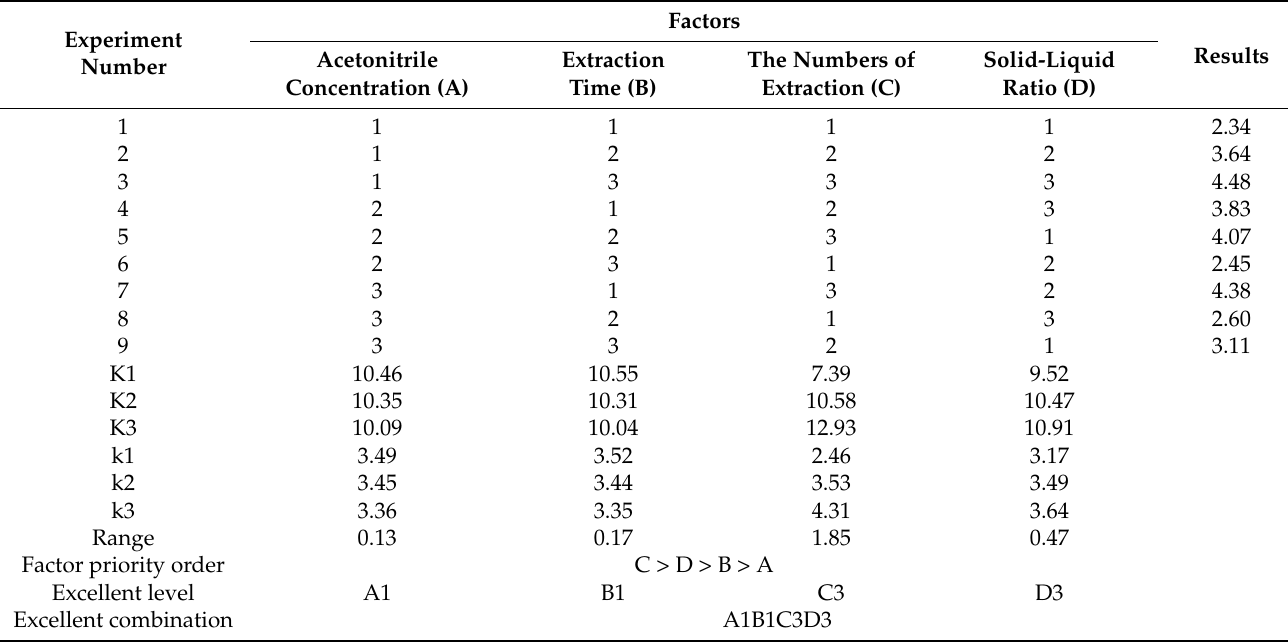
Table 2. Orthogonal test and measurement results.